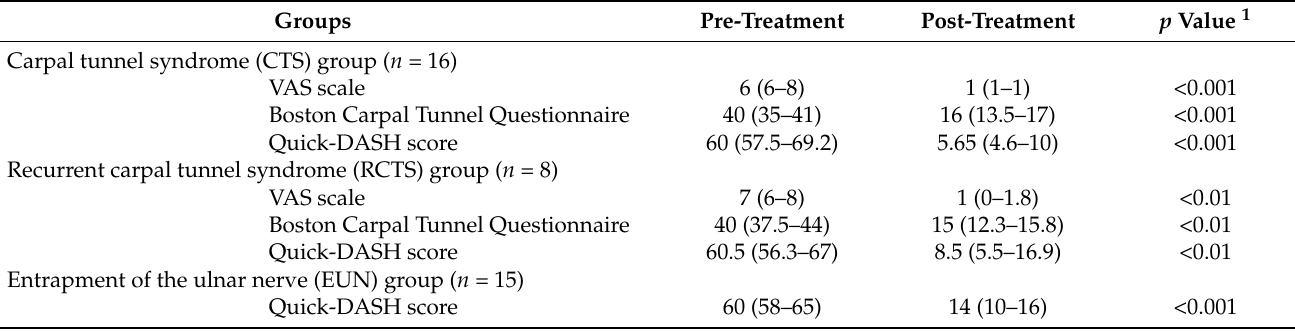
Figure 2. Box-and-whisker plots showing the results of the carpal tunnel syndrome for visual analogue scale (VAS), Boston Carpal Tunnel Questionnaire (BCTQ), and Quick-DASH score. The boxes show the median and interquartile range (IQR), and the whiskers indicate the 25th percentile − 1.5 × IQR, and the 75th percentile − 1.5 × IQR. The square points indicate outliers outside the whisker range. *** indicates p < 0.001 ( n = 16). Table 2. Comparison of changes in patient-reported outcomes. Results are reported as median [interquartile